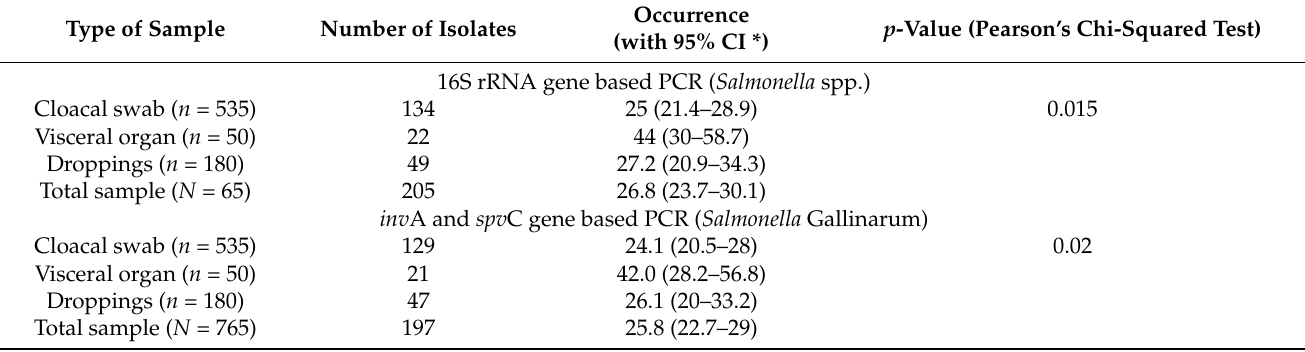
Table 4. Occurrence of Salmonella isolates in different samples collected from 12 layer flocks from five divisions of Bangladesh as confirmed though molecular assays.